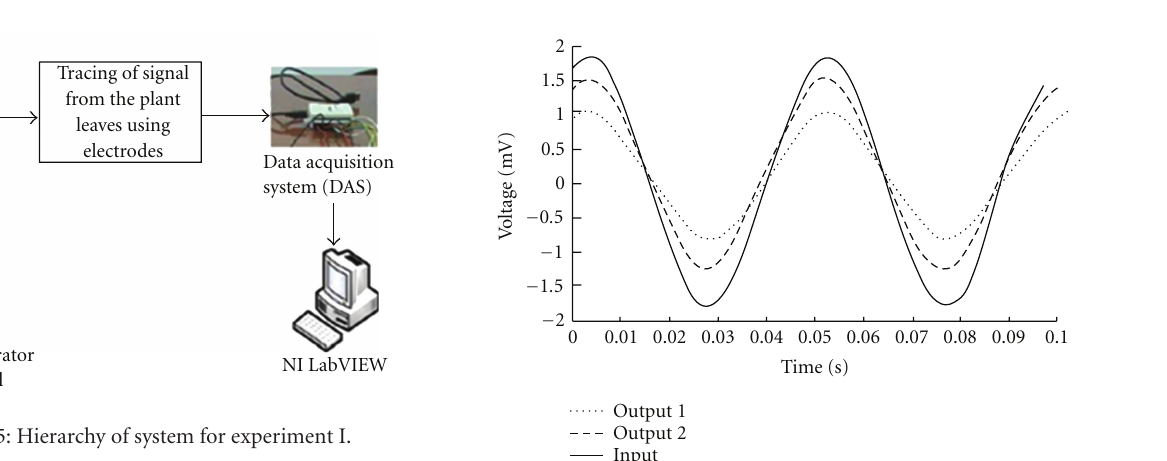
Figure 5: Hierarchy of system for experiment I.